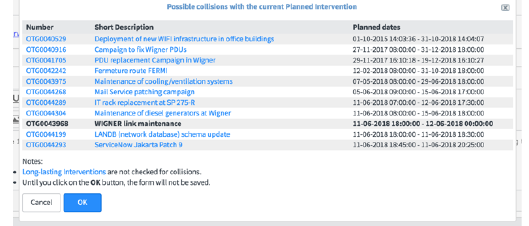
Fig. 2. Dialogue showing the preview of possible collisions with other interventions or